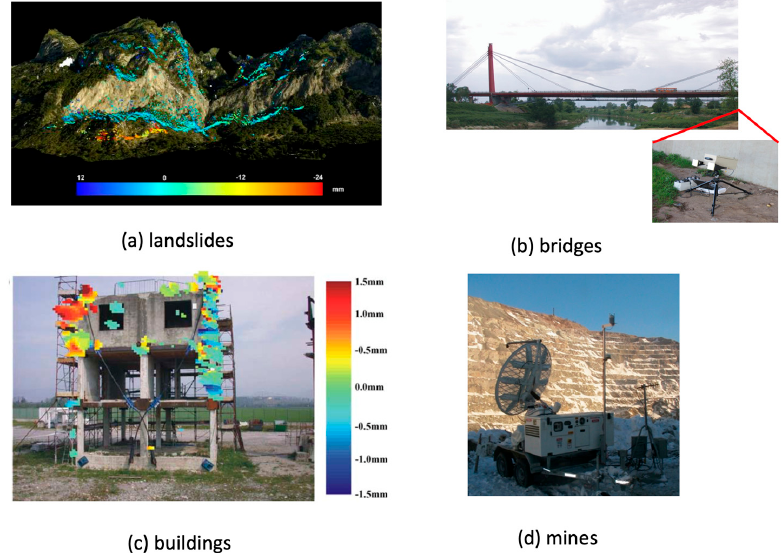
Figure 8. Examples of applications of GBRI: ( a ) landslide monitoring (after [58]), displacement map and picture projected on the digital elevation model of the slope; ( b ) monitoring of a viaduct in Florence, Italy; ( c ) displacement map projected on the picture of the monitored building (after [22]); ( d ) mines monitoring, radar deployed in Thompson Creek Mine, Idaho, USA (after [59]).